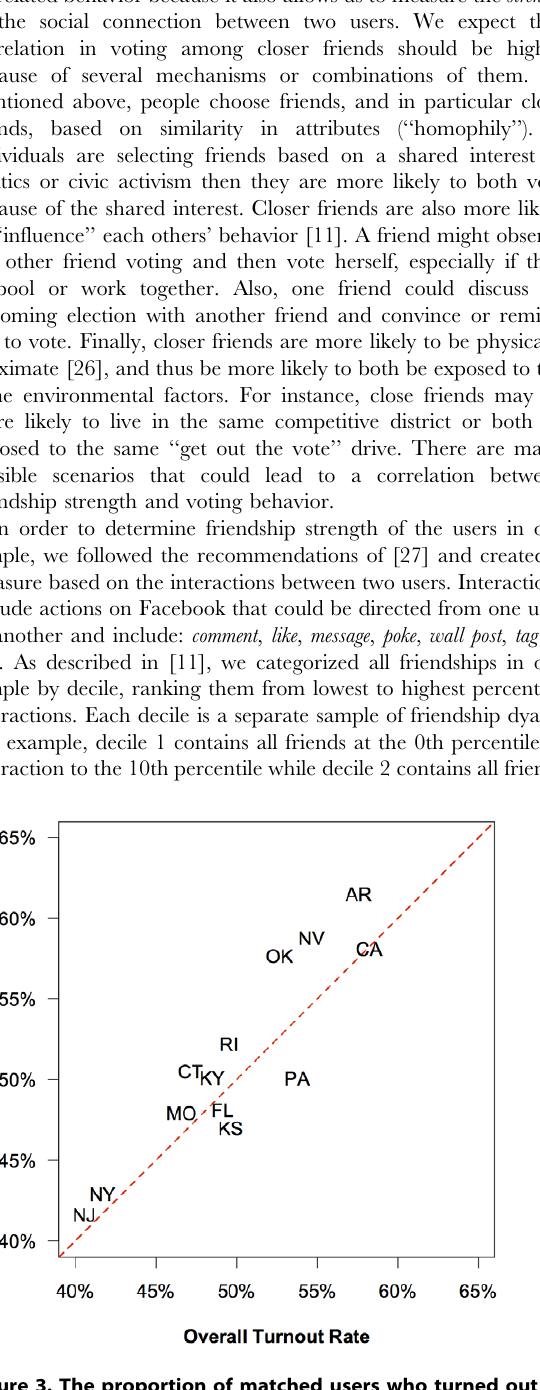
Figure 3. The proportion of matched users who turned out to vote compared to the overall turnout rate by state. Note that the abbreviation for Kansas is repositioned slightly so that it does not overlap with the abbreviation for Florida. The results show that the Yahtzee procedure produces about the same overall turnout rate for each state as that shown in the official voter record.